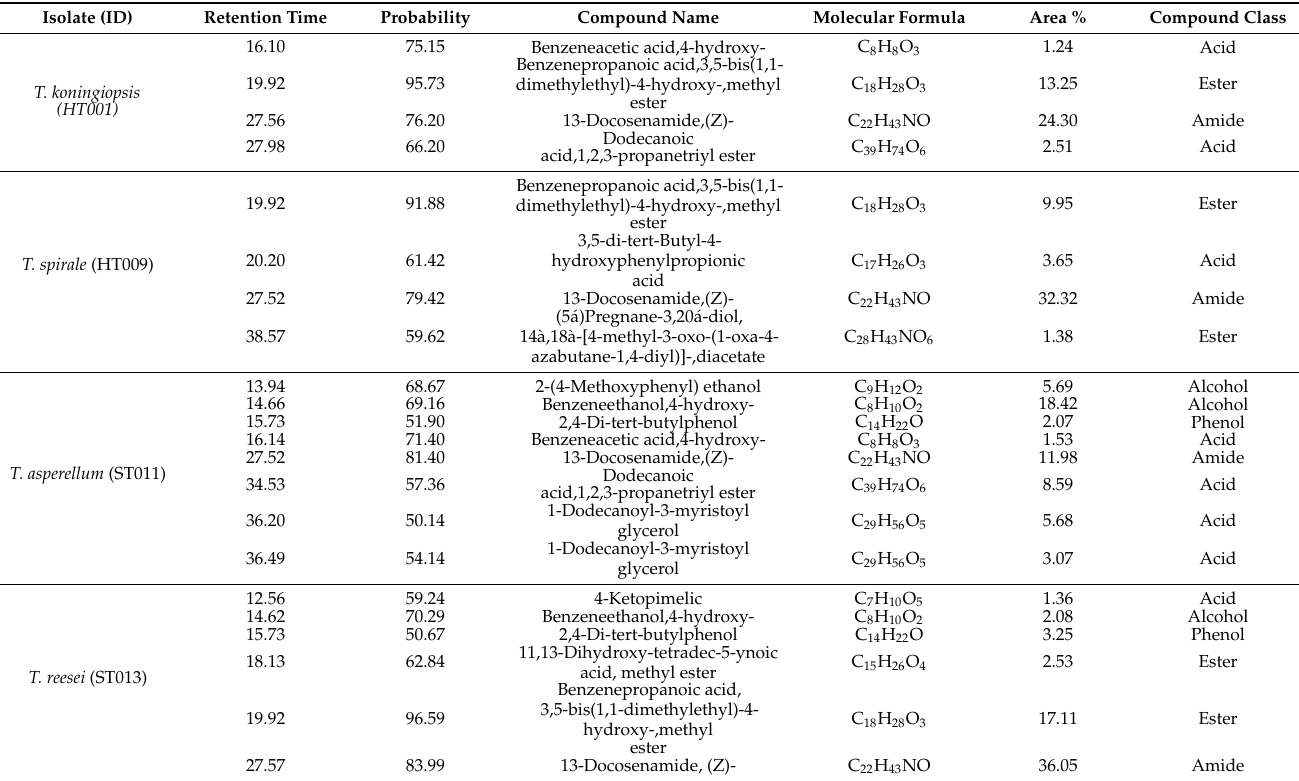
Table 7. The main compounds identified in the methanol extracts of Trichoderma isolates by GC-MS, each having a >1% peak area and a ≥ 50% match quality in the NIST-17 library